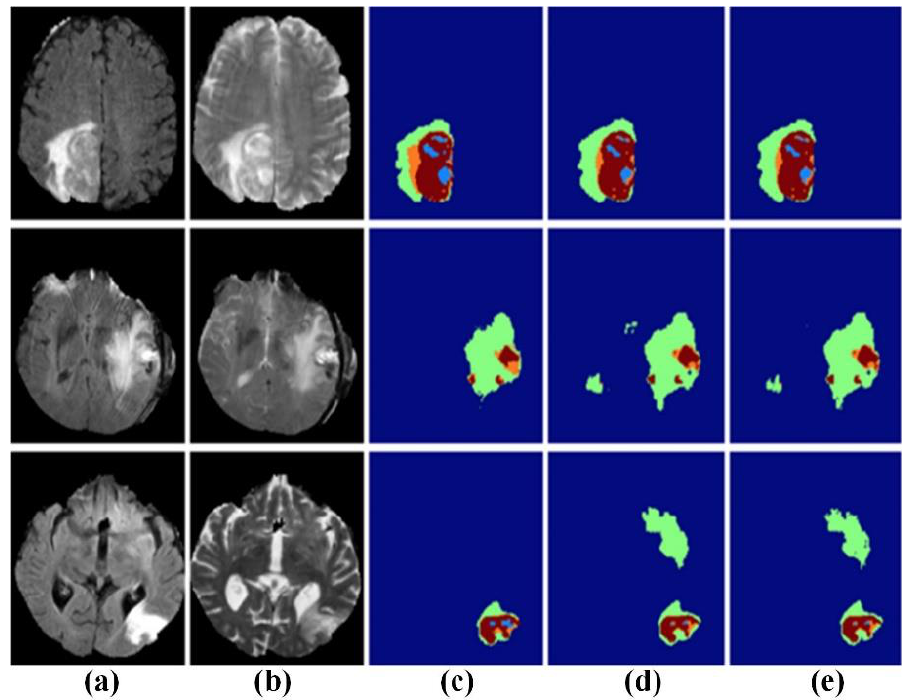
fectively migrated to medical image analysis tasks, including MRI brain tumor segmenta- Figure 21. Brain tumor segmentations by 3D CNN. ( a ) Flair. ( b ) T2. ( c ) Manual. ( d ) Deep Medic. Figure 21. Brain tumor segmentations by 3D CNN. ( a ) Flair. ( b ) T2. ( c ) Manual. ( d ) Deep Medic. ( e ) tion. Table 6 is the performance of the MRI brain tumor segmentation method based on ( e ) Deep Medic + CRF. Deep Medic + CRF. the GAN. Table 5. Evaluation results of MRI brain tumor segmentation based on the multi-CNN network.